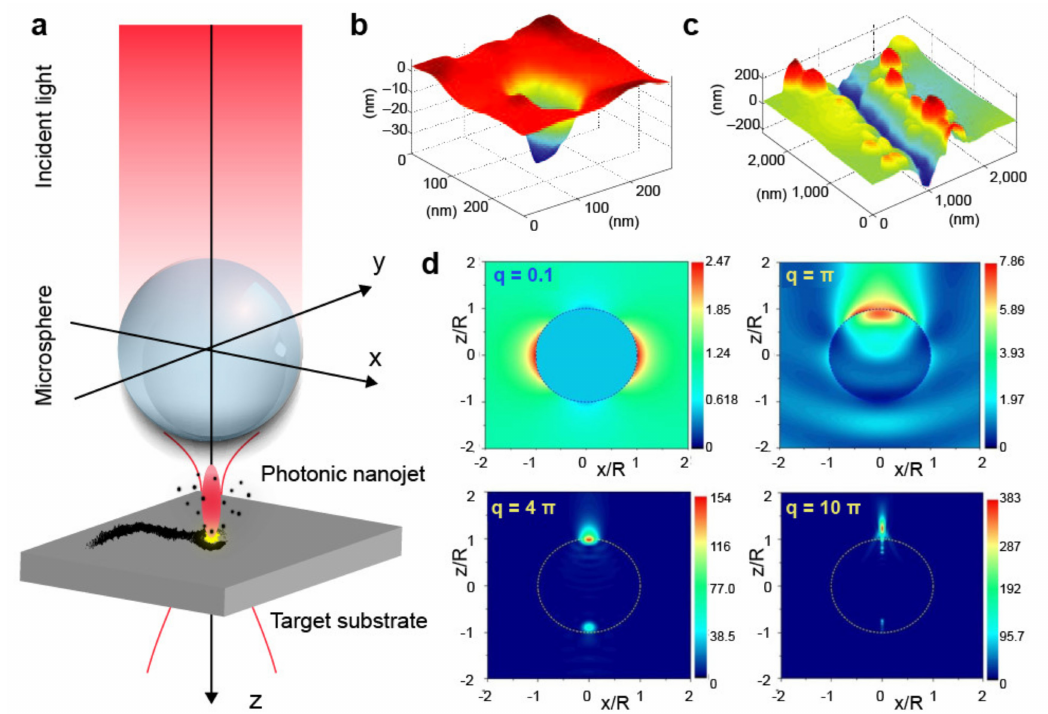
Figure 1. ( a ) Schematic description of photonic nanojet-mediated nanopatterning using a microsphere. ( b , c ) Atomic force microscope (AFM) topography maps of a nanohole ( b ) and a nanochannel ( c ) ablated on a polycarbonate substrate using a photonic nanojet and pulsed irradiation. Adapted with permission from [20]. Copyright 2008 Springer Nature. ( d ) Theoretical intensity distributions of the optical field generated by a dielectric microsphere ( n p = 1.5 and n m = 1.0) under plane-wave illumination and for different values of the size parameter q . Linearly polarized light along the x -axis is incident from the bottom. Adapted with permission from [17]. Copyright 2017 Optical Society of